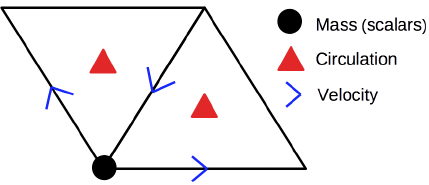
Figure 3. Lozenge: basic computational element containing one node (for mass and other scalars), three edges (for velocities) and two triangles (for circulation). Separate wavelet transforms are pro- vided for the nodes (scalar valued) and edges (vector valued). The adaptive grid consists of the significant nodes and edges, together with nearest neighbours in position and scale necessary for dynam-